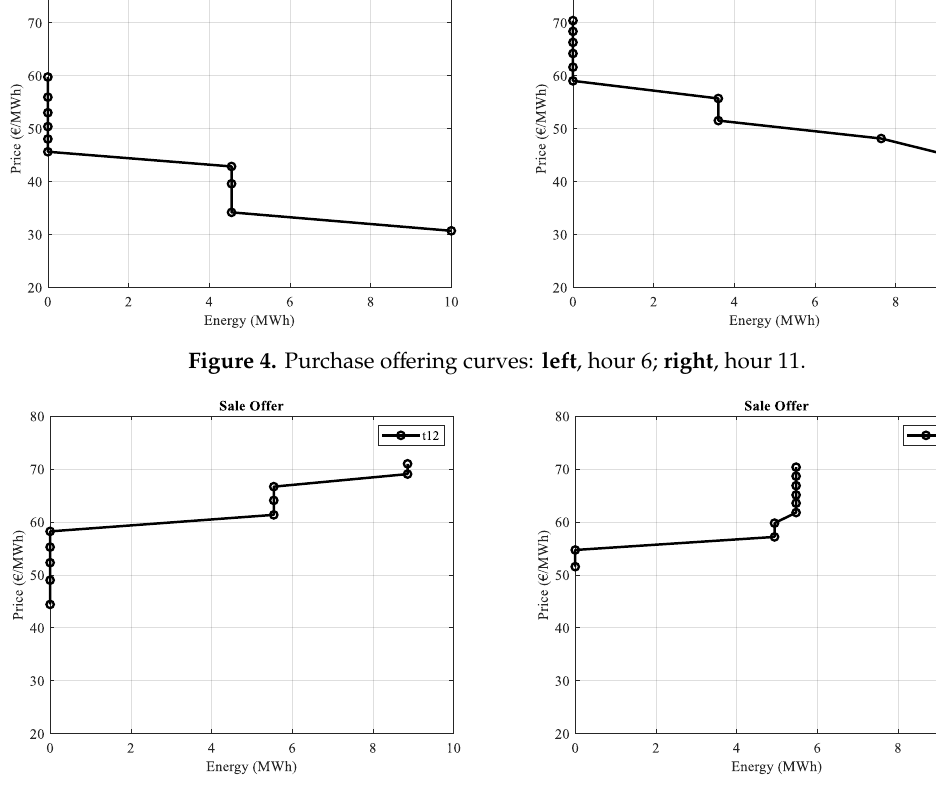
Figure 5. Sale o ff ering curves: left , hour 12; right , hour Figure 5. Sale offering curves: left , hour 12; right , hour 22. Figure 5. Sale offering curves: left , hour 12; right , hour 22.